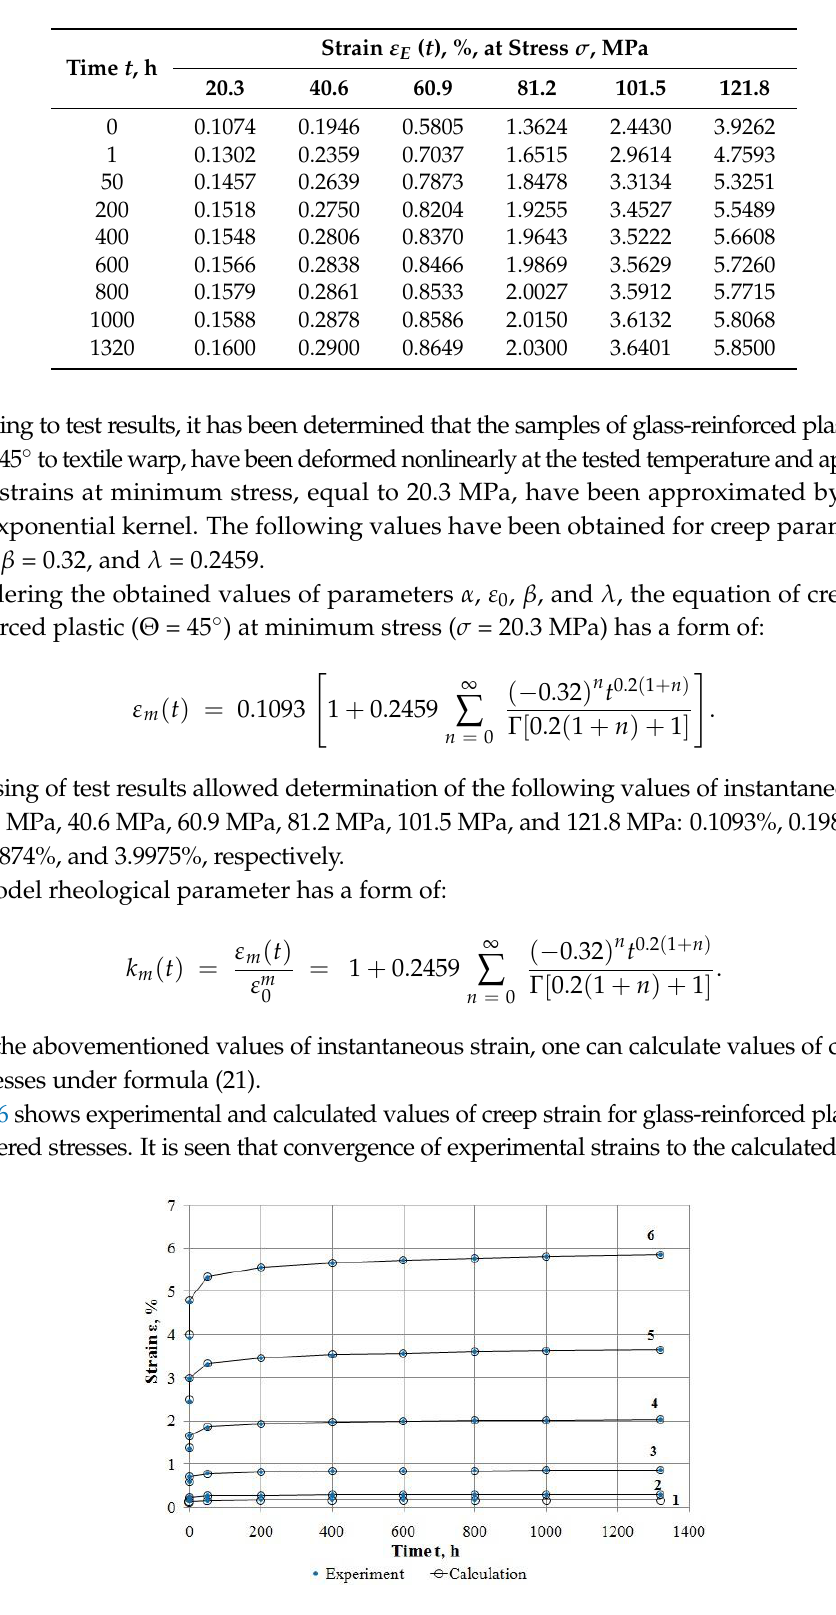
Table 3. Values of creep strain for glass-reinforced plastic ( Θ = 45 ◦ ).